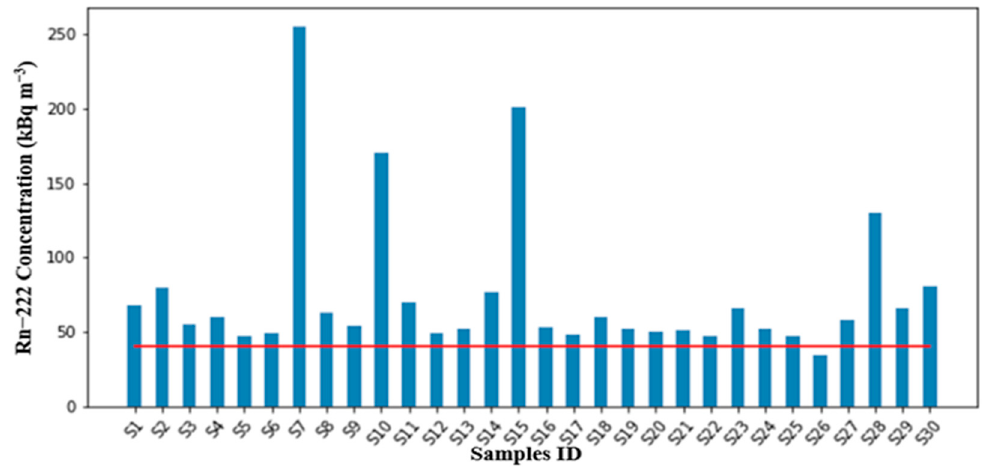
Figure 3. 222 Rn distribution in soil of the bauxite bearing area of Fongo-Tongo.